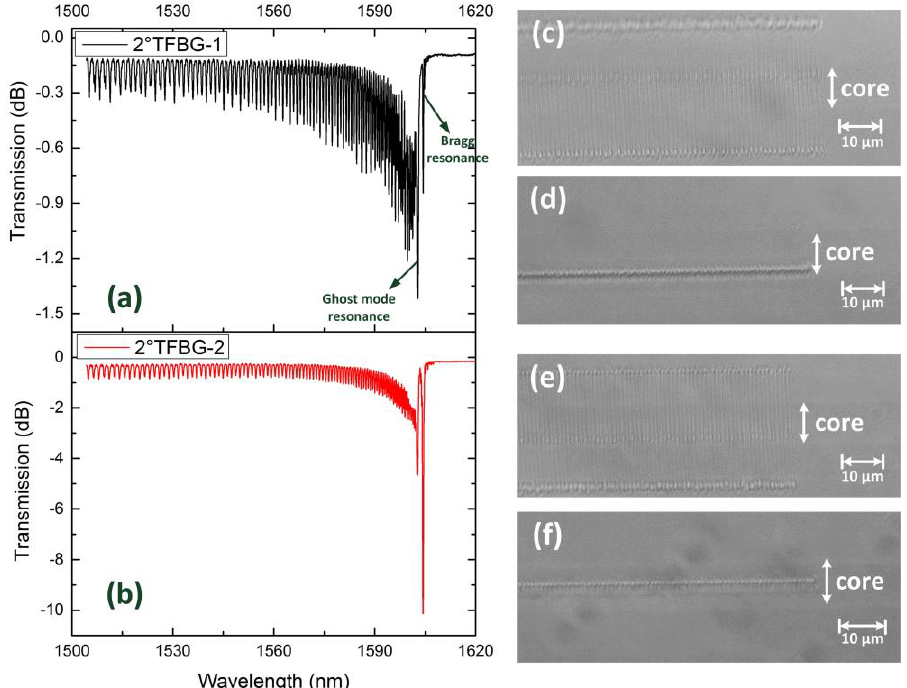
Figure 2. Transmission spectrum of ( a ) 2°TFBG-1 and ( b ) 2°TFBG-2. Microscopy image (100×) of 2°TFBG-1: ( c ) top view and ( d ) side view. Microscopy image (100×) of 2°TFBG-2: ( e ) top view and ( f ) side view.